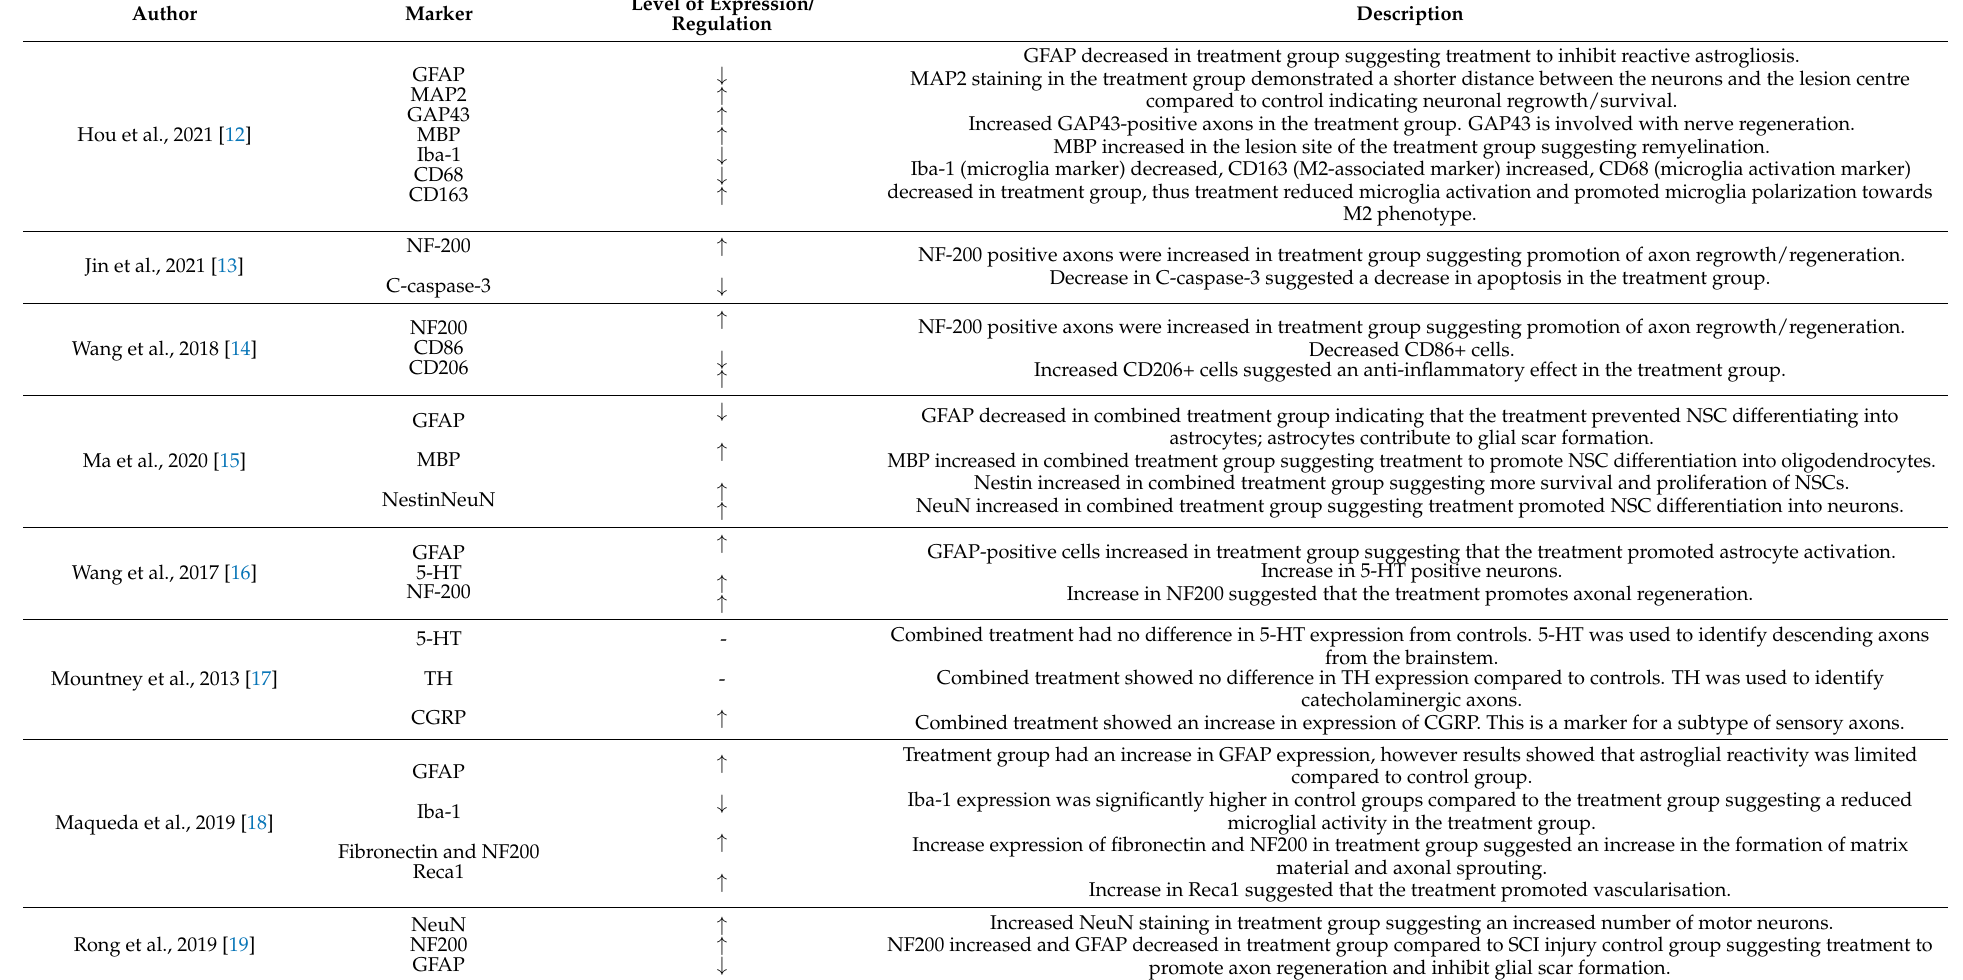
Table 3. Immunohistochemical outcomes in